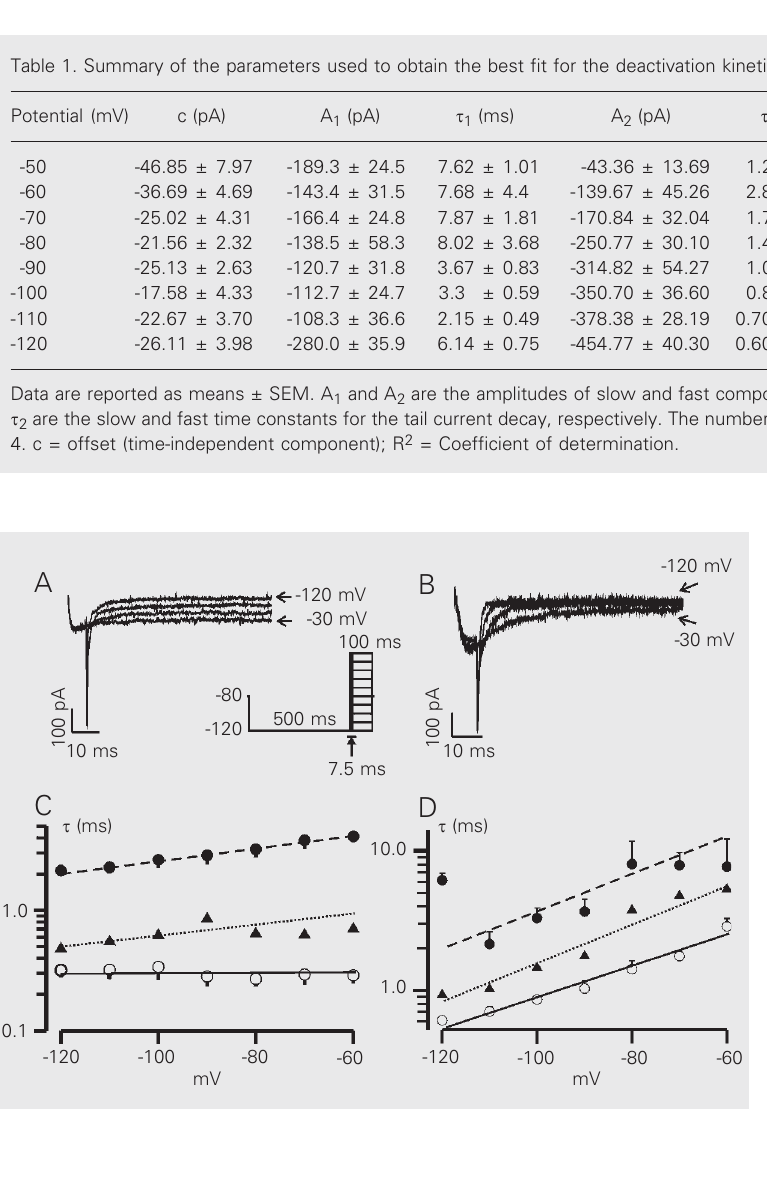
Table 1. Summary of the parameters used to obtain the best fit for the deactivation kinetics. Potential